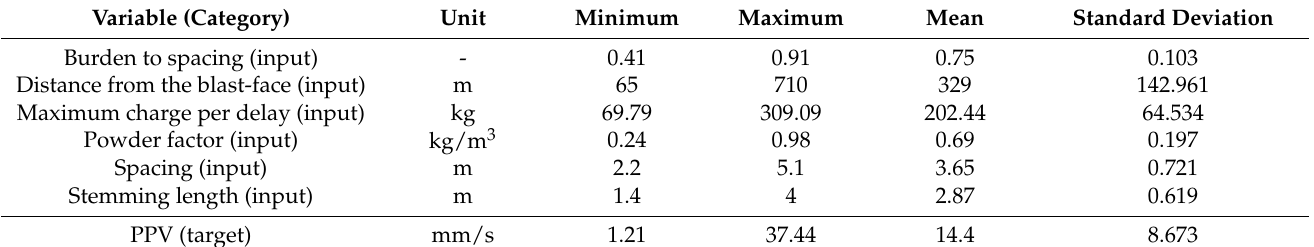
Table 2. Summary of parameters in the projecting models.